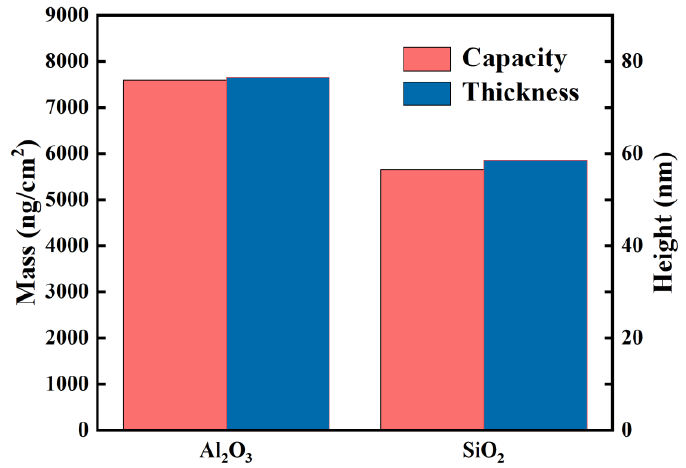
Figure 10. Adsorption amount and adsorption layer thickness of PEO on alumina and silicon.